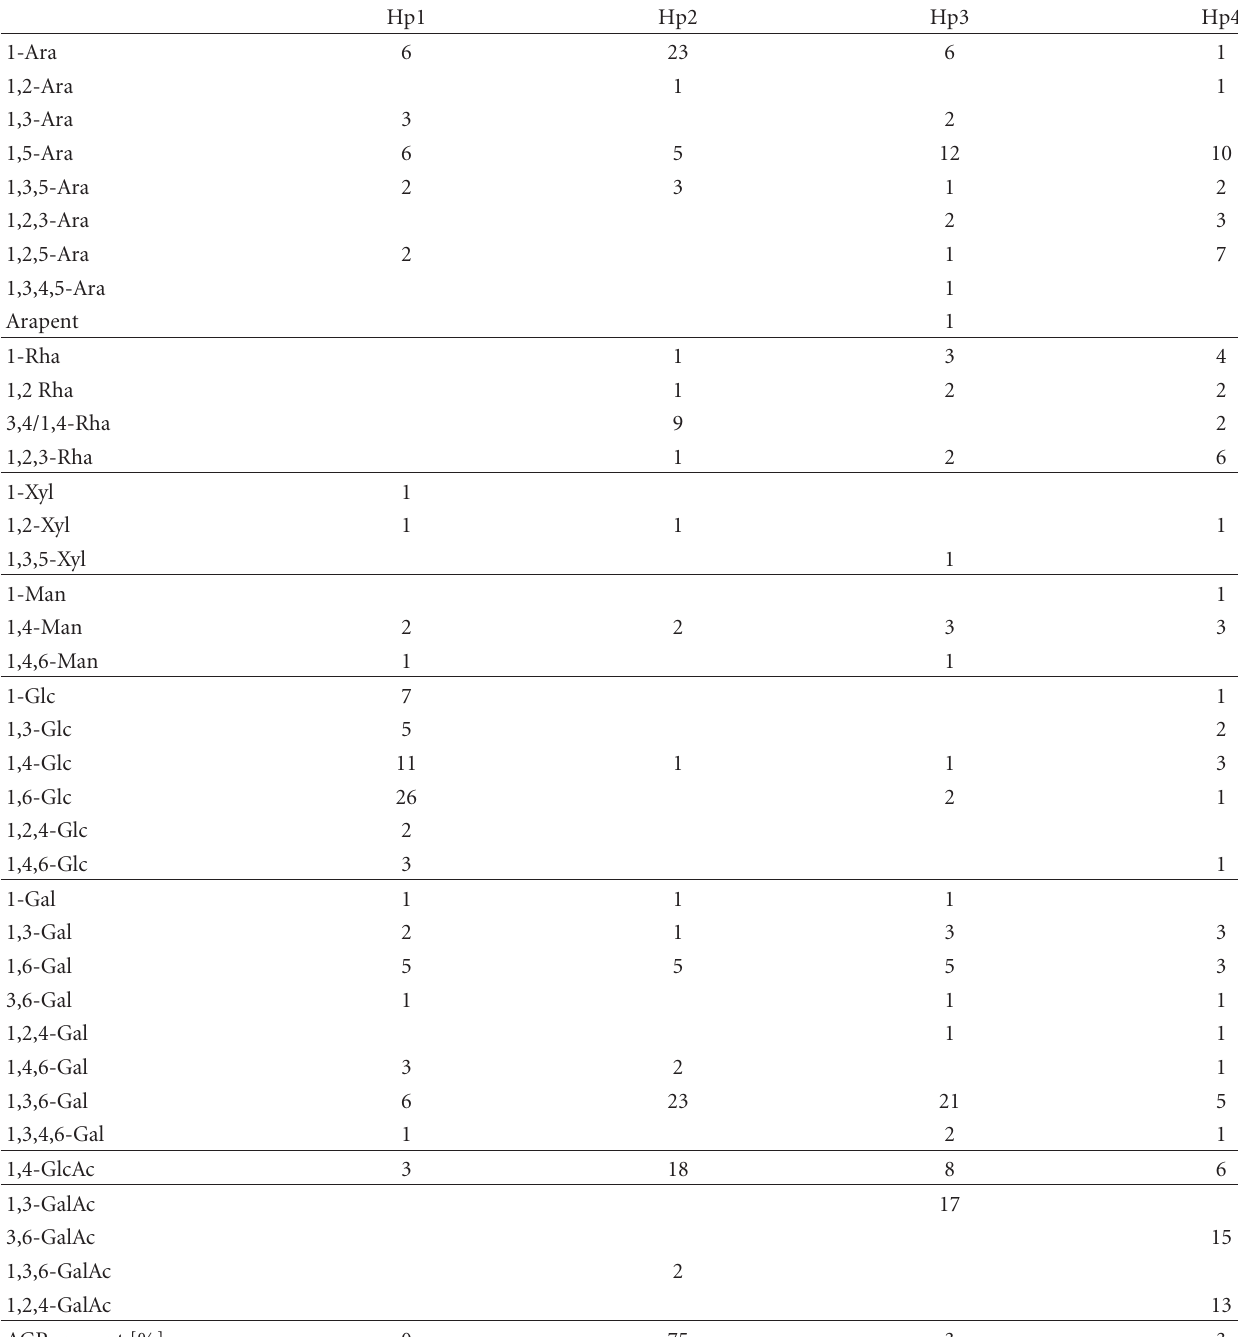
Table 2: Results of methylation analysis and AGP determination of St. John’s Wort polysaccharides. Data indicate the respective molar composition [%], calculated from results of HPAEC-PAD and silylation analysis. AGP amounts were detected by the agar di ff usion test according to van Holst and Clarke, 1985